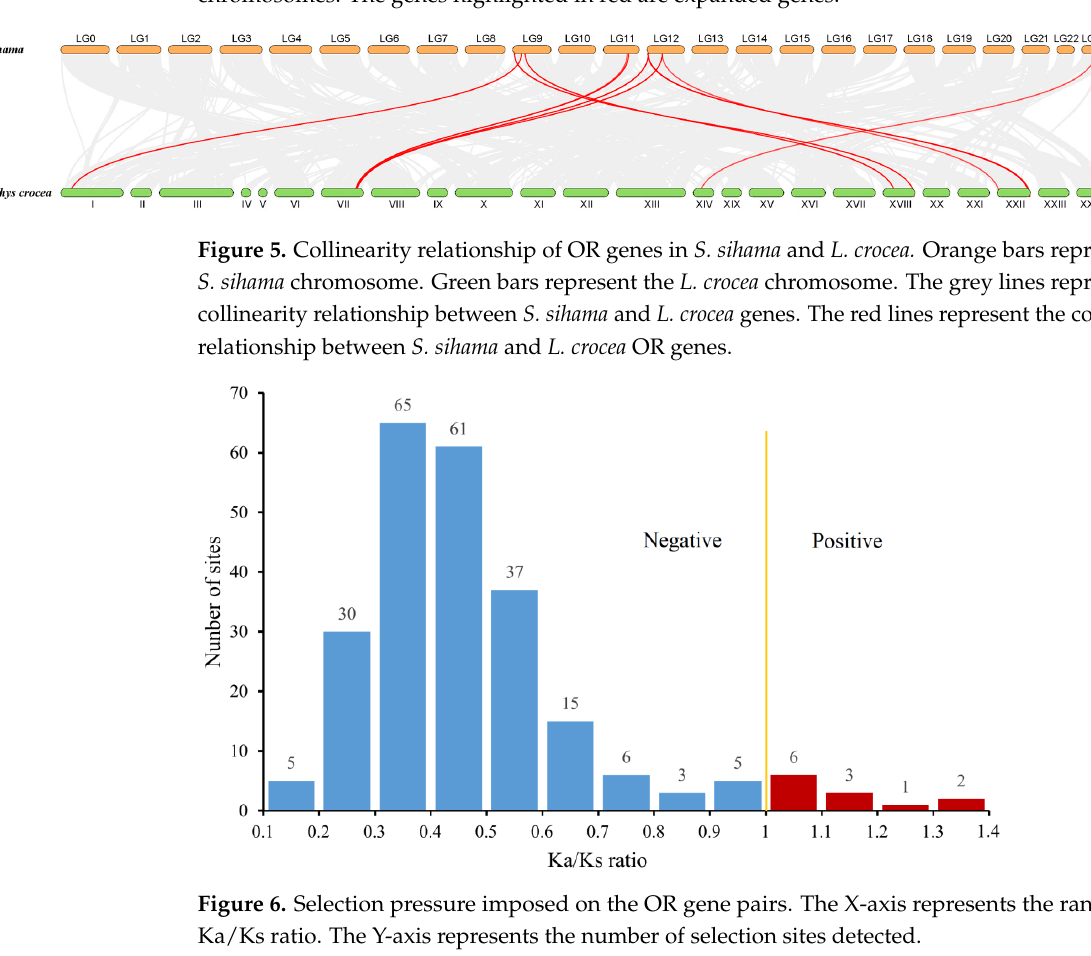
Figure 6. Selection pressure imposed on the OR gene pairs. The X-axis represents the range of the Ka/Ks ratio. The Y-axis represents the number of selection sites Ka/Ks ratio. The Y-axis represents the number of selection sites detected.